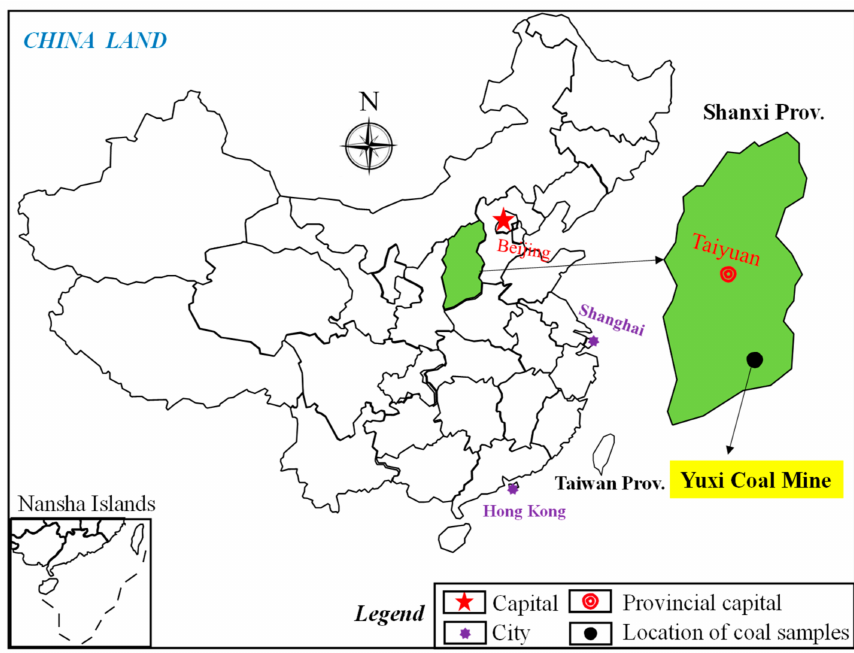
Figure 1. Geographical location of